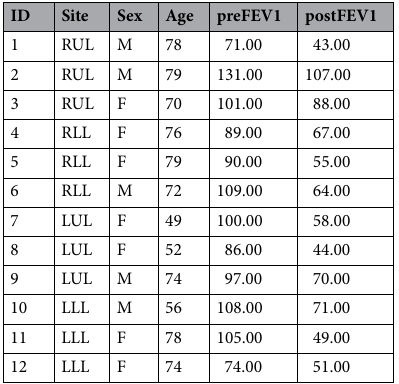
Table 1. Study population. For each patient, the location of the lobectomy site, sex, age and clinically measured forced expiratory volume in the 1st second (FEV1) before (preFEV1) and after (postFEV1) the surgery is